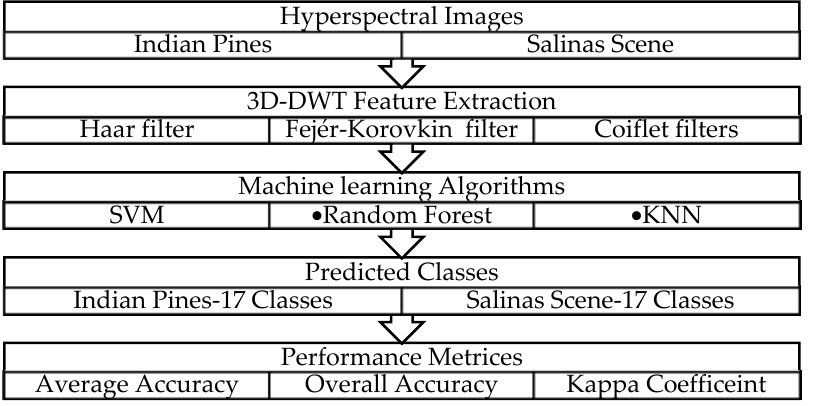
Figure 1. Schematic representation of proposed hyperspectral data processing flow.